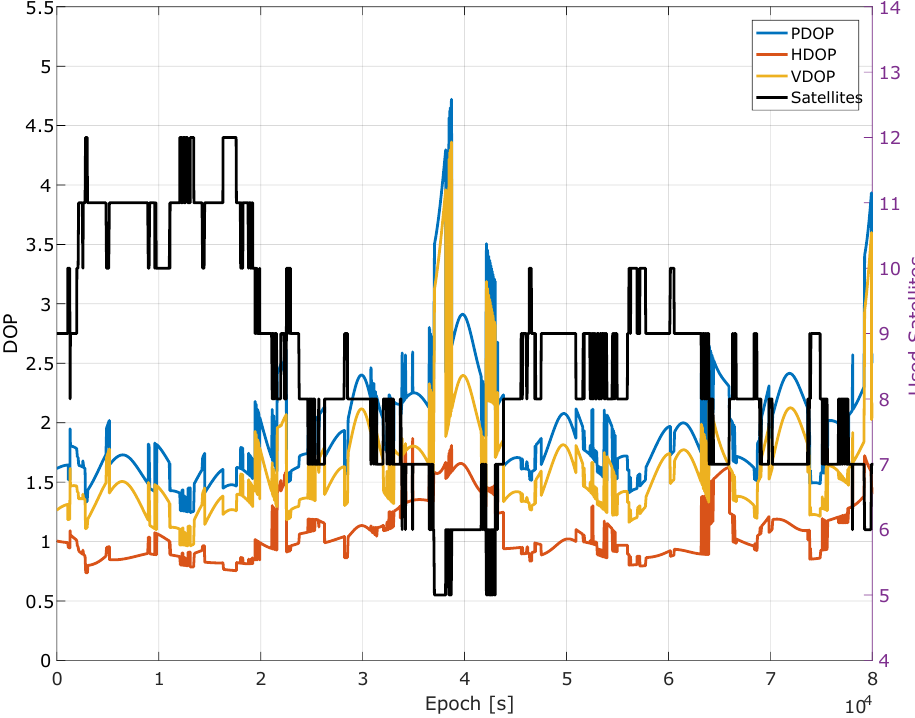
Figure 2. Dilution of Precision (DOP) values and number of satellites as a function of